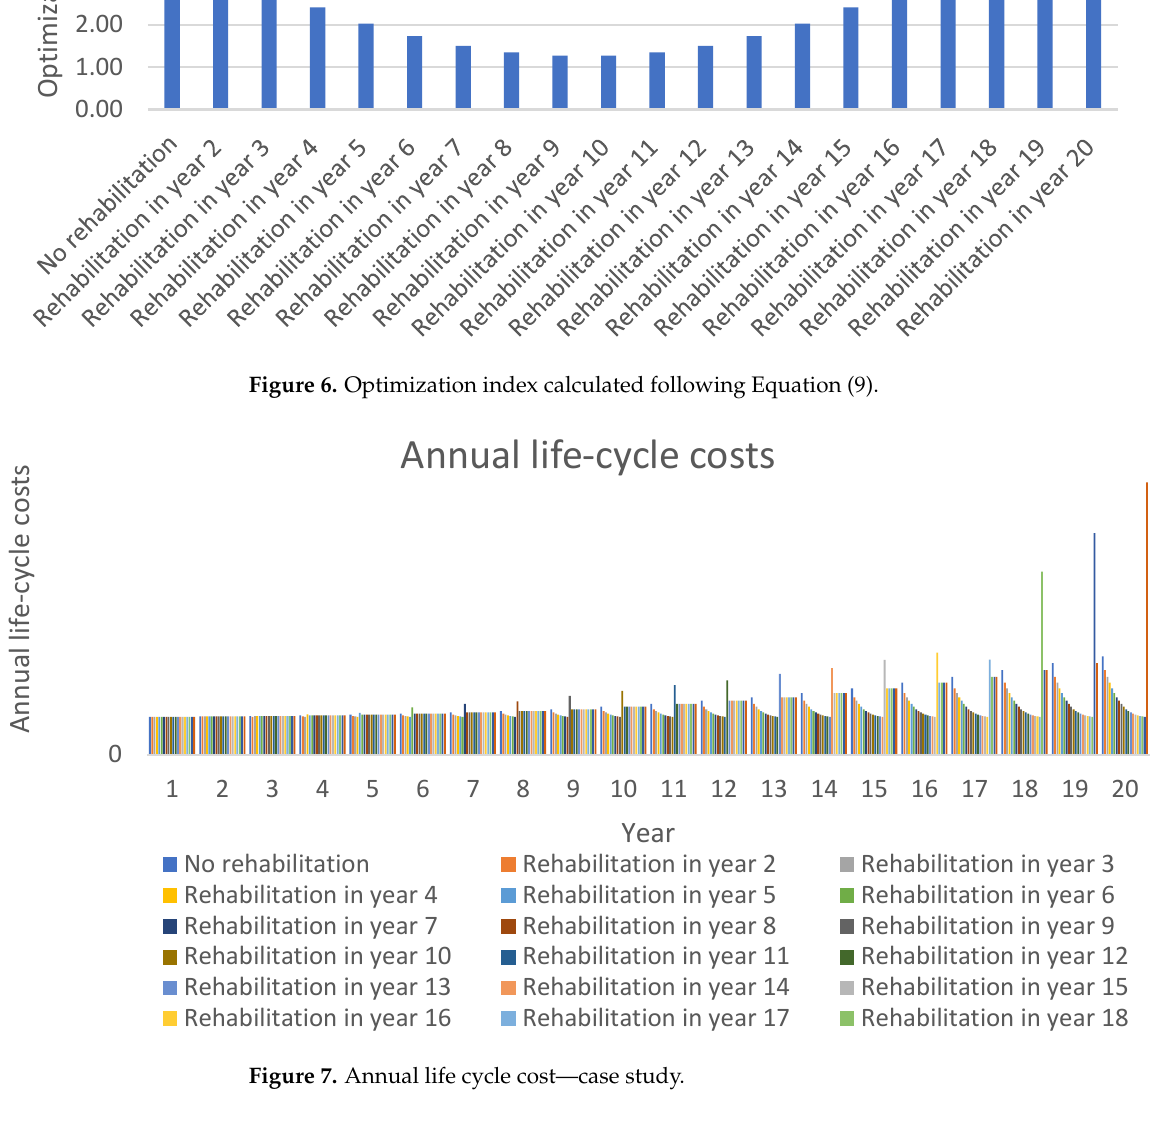
Figure 8. Optimization index — case study. 6. Conclusions Asset management (AM) is considered a crucial tool needed for the management of a road network to satisfy the requirements of different stakeholders. The usual practice of operative rehabilitation planning is to rely on a pavement management system (PMS) that considers technical aspects of pavement operation and perhaps rudimentary cost-benefit analysis methods. PMS are usually viewed as essential, but subsidiary sub-modules of the AM. Here, the presented method incorporates the AM principles of optimizing asset value under financial constraints directly into the pavement rehabilitation planning procedures. AM usually omits or simplifies technicalities such as pavement bearing capacity and re- sidual service life calculations based on the rheological properties of paving materials and pavement performance models. It relies on PMS to deal with these technicalities and uses the results and indicators of PMS as input for asset value calculation on a road network level. The practical application of the presented method proves that AM can be used, not